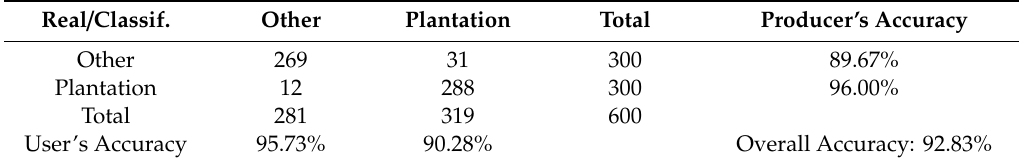
Table 6. Evaluation of chestnut plantation area predictions obtained using Model 3 (model created applying SVM). Ground truth data were created with a random stratified sample of 600 points. Real / Classif.